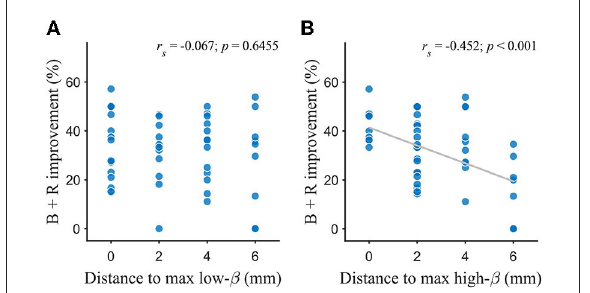
FIGURE2 Association between the DBS efficacy and the distance between the contact with the maximum oscillations and the